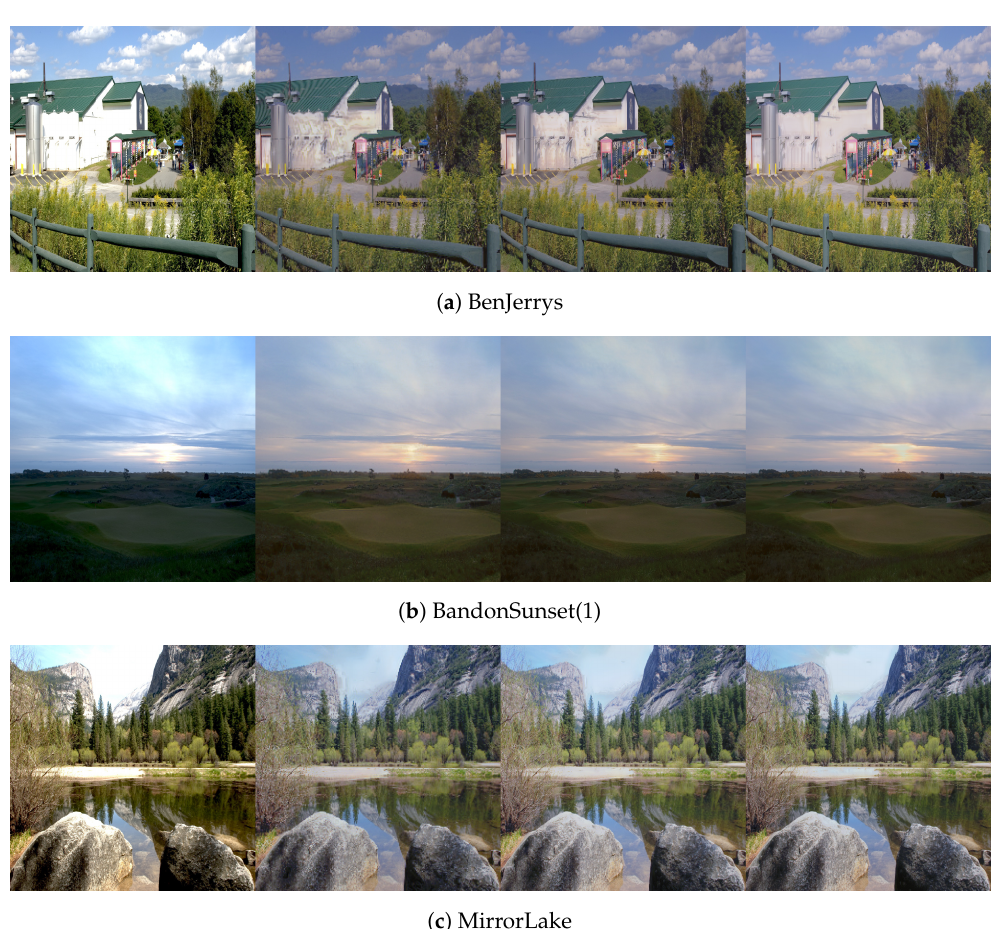
Figure 6. Test-set predictions for inputs at varying resolutions. First column is the input LDR, followed by predictions at resolutions of 256 × 256, 512 × 512 and 1024 × 1024,